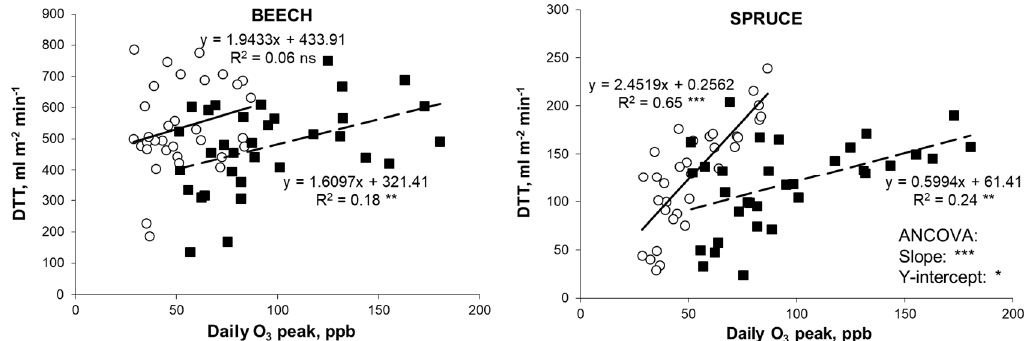
Figure 2. Daily total transpiration (DTT) increased with increasing daily ozone peaks in mature trees of European beech and Norway spruce exposed to ambient ( ○ solid line) and twice-ambient O 3 regimes ( ■ , dashed line) (July 2007). Each point is the average of 4–5 trees. Asterisks show the significance of the analysis: ***, p < 0.001; **, p < 0.01; *, p < 0.05; ns, p ≥ 0.05.